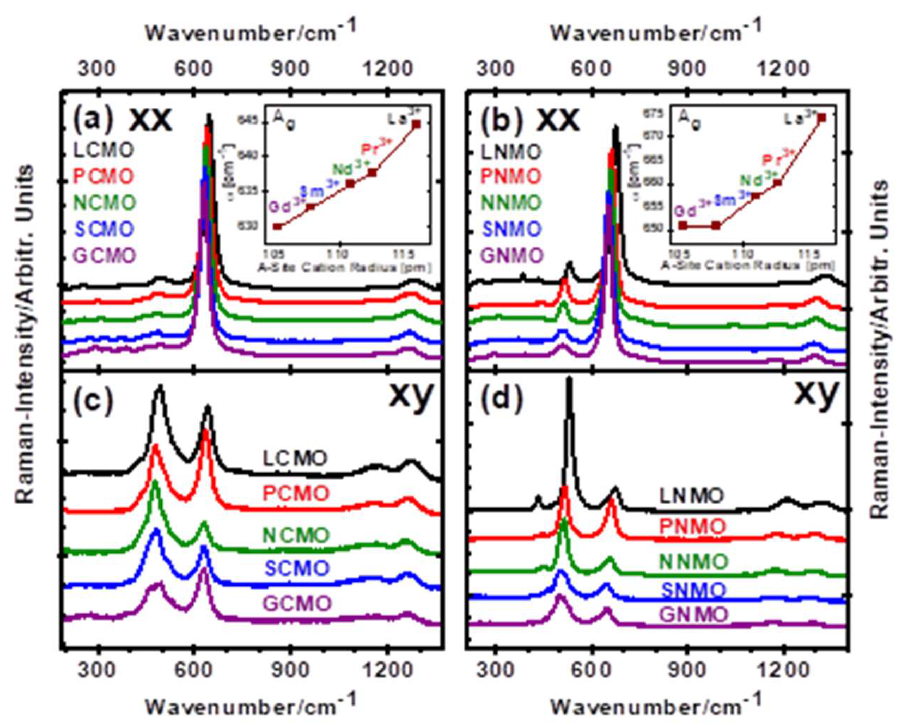
Figure 2. Polarized Raman spectra (at T = 300 K) of the two double-perovskite A 2 CoMnO 6 ( a , c ) and A 2 NiMnO 6 ( b , d ) thin film series on STO(111) in the parallel XX-scattering configuration ( a , b ) and in the crossed XY-scattering configuration ( c , d ). The insets in ( a , b ) show the development of the position of the Ag breathing modes of the A 2 CoMnO 6 and A 2 NiMnO 6 film series in the Raman spectra with XX-scattering configuration as a function of the A-site rare earth cation size.